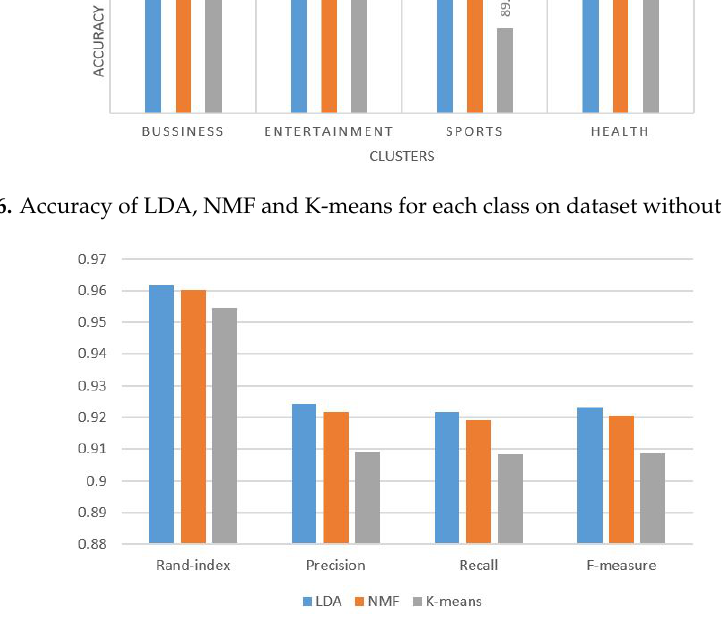
Figure 7. Performance measure of LDA, NMF and K-means by Rand-index, precision, recall and F-measure on dataset without